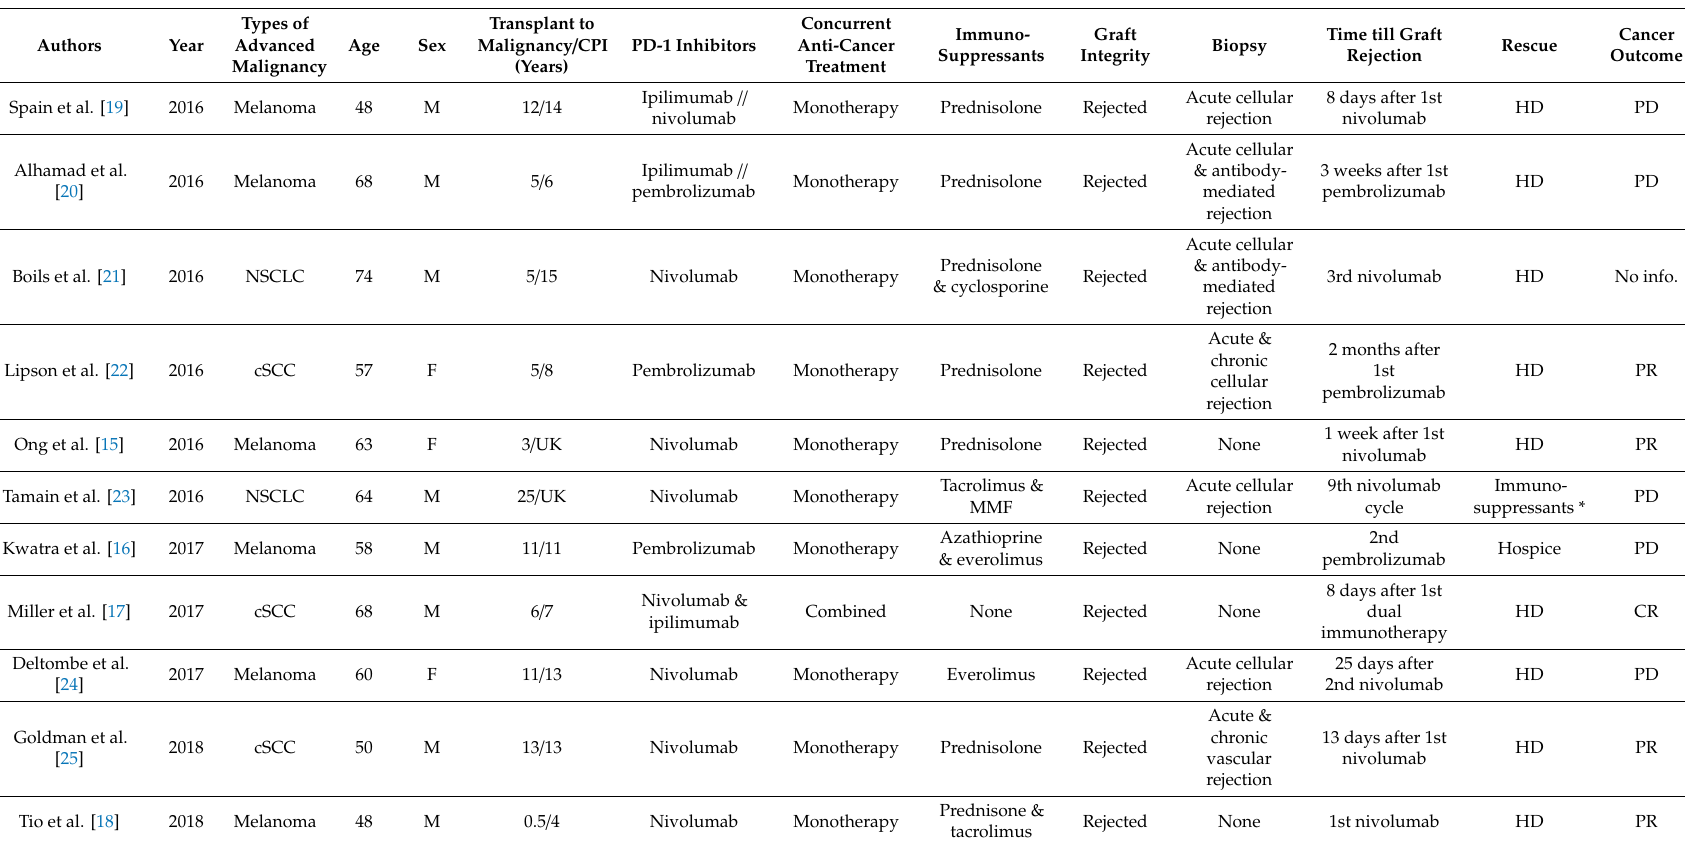
Table 1. Clinical response and graft rejection after PD-1 inhibitors in various advanced malignancies of renal transplant